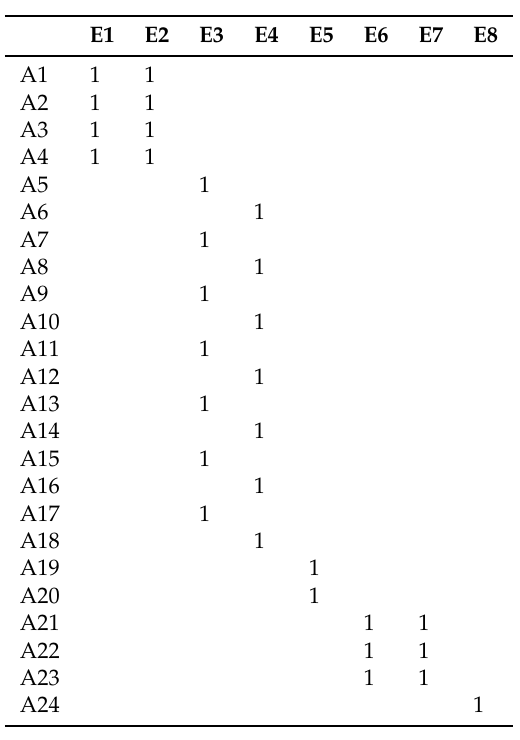
Table 5. Activity–equipment matrix that defines which equipment are required to perform a given activity.